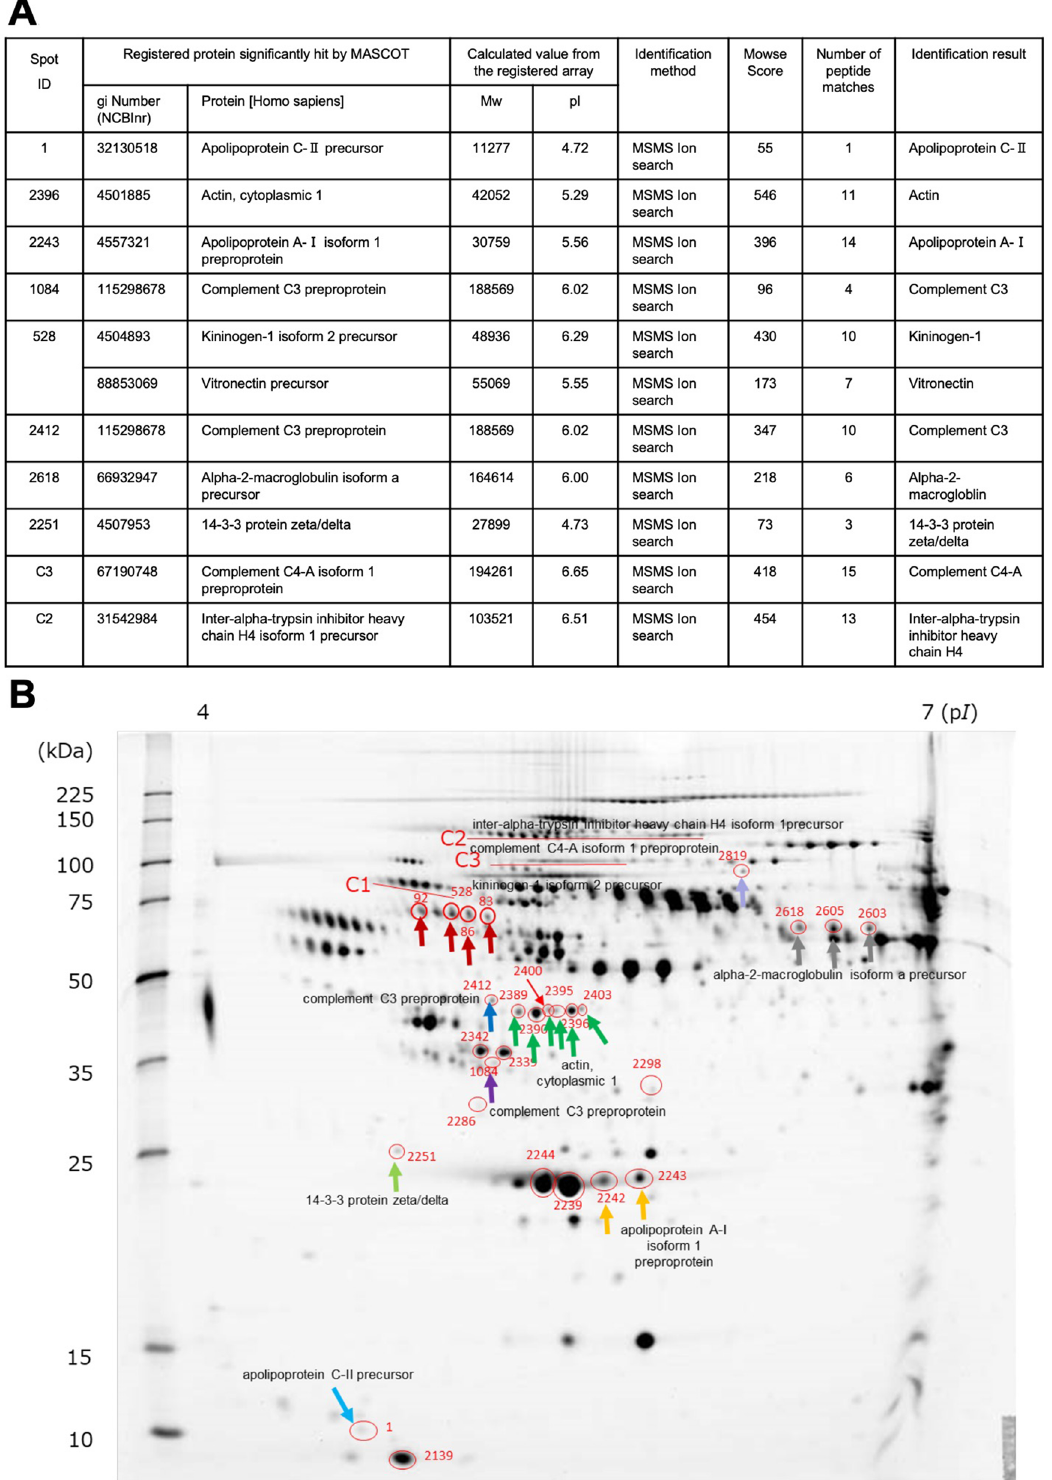
Figure 3. ( A ) Gel pieces containing ten spots and spot clusters, having mean concentration of 2.5 times or higher ( P < 0.05) in the Takayasu arteritis (TAK) patient group compared with the healthy control group, were cut out, and the peptides were extracted and measured using matrix-assisted laser desorption/ionization time-of-flight/ time-of- flight mass spectrometry (Ultrafle Xtreme, Bruker Daltonics, Billerica, MA, USA). Indicated table shows the measured values for the registered sequences, Mowse scores, number of peptide matches and identification results. ( B ) A representative image of the two-dimensional electrophoresis and fluorescence staining using a patient plasma sample (Takayasu arteritis (TAK) patient group: sample #5). Red circles indicate protein spots and spot clusters whose sums of the means are 1.5 times or higher in the TAK patient group compared with that in the control group. The arrows indicate spot and spot cluster names of the proteins detected by mass